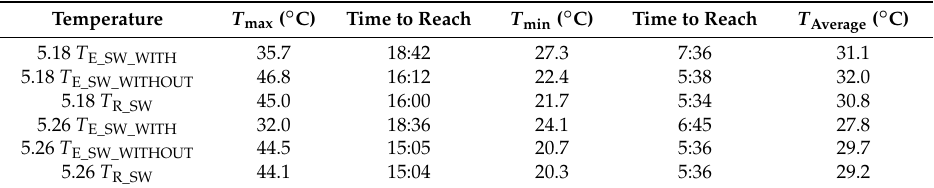
Figure 11. Temperature comparison diagram of south-facing wall.